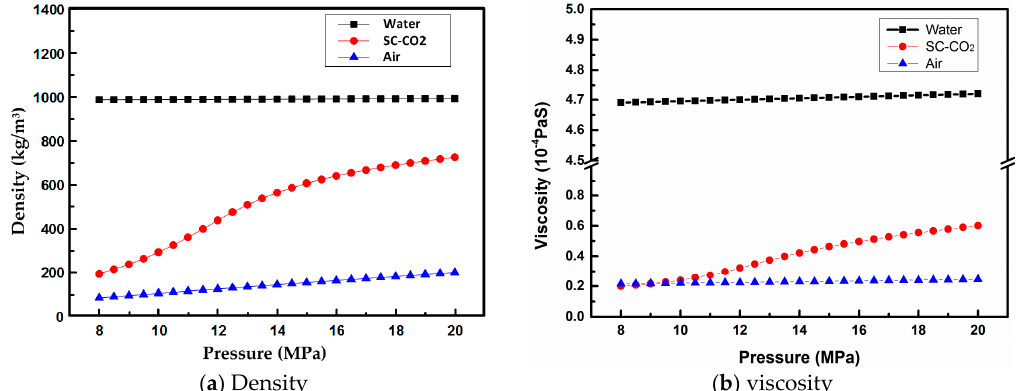
Figure 2. Density and viscosity of SC-CO 2 , water and air (Temperature = 333 K).